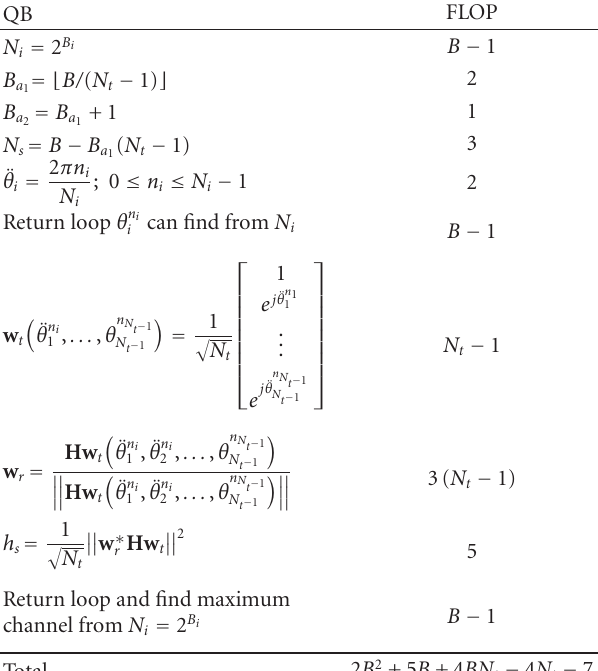
Table 2: The process of formation of FLOP with the QB.